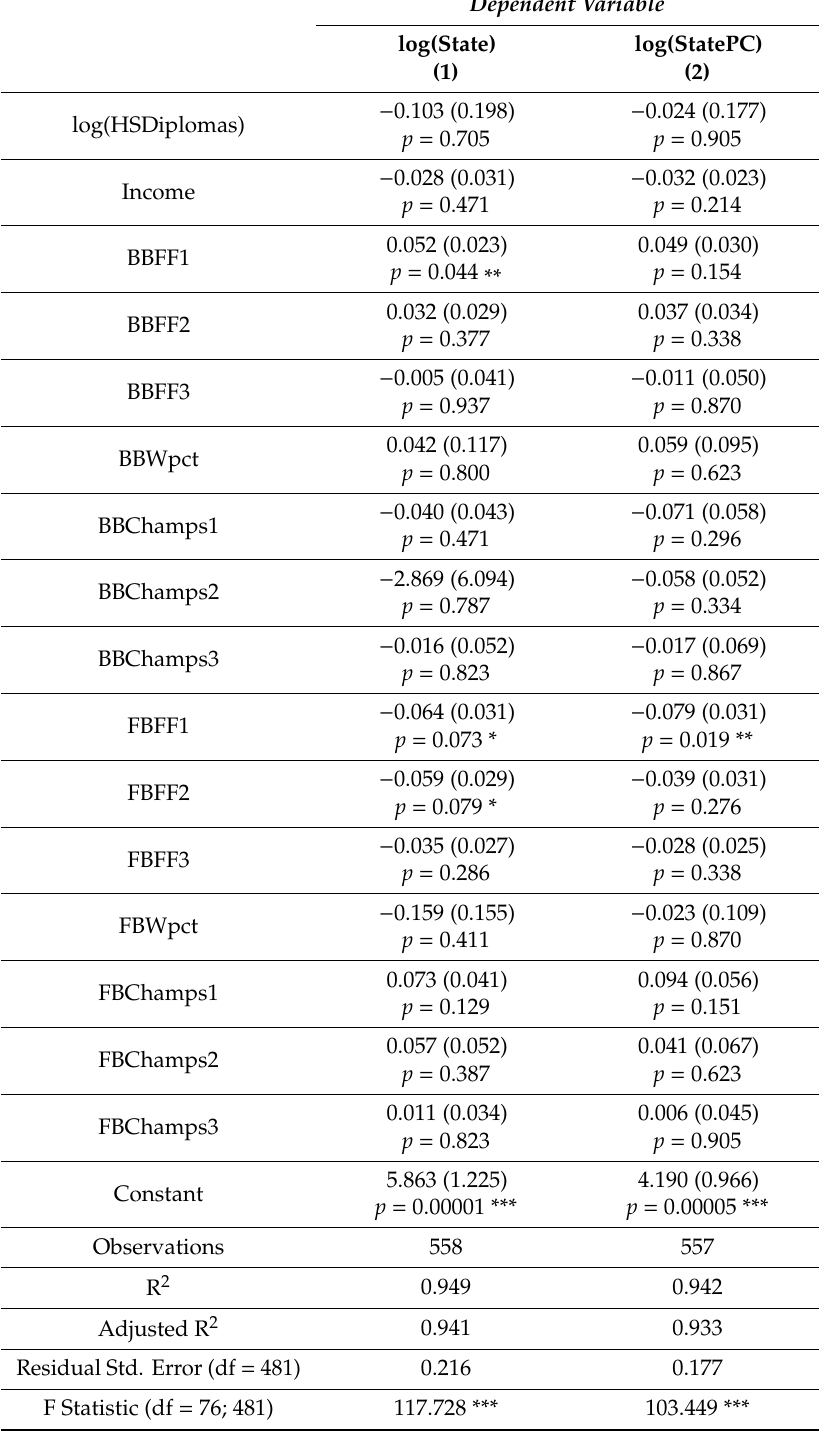
Table 6. Models for